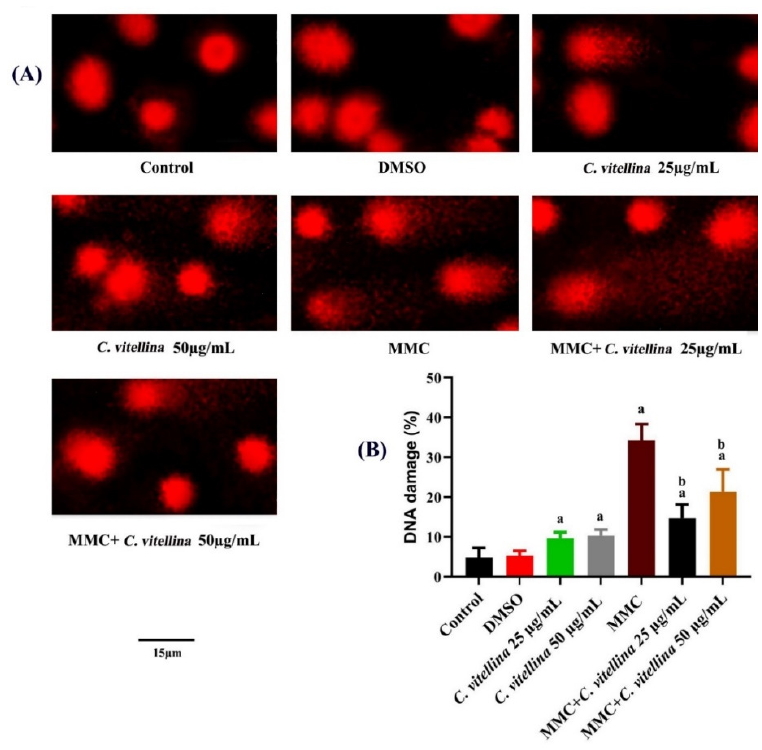
Figure 6. Photomicrographs of alkaline comet assay ( A ) showing the ameliorative e ff ect of C. vitellina extract on HPBL DNA-single strand breaks as evaluated by the migration of fragmented DNA after 24 h of treatments against MMC-induced genotoxicity (ethidium bromide staining, Olympus BX 41 fluorescent microscope, Tokyo, Japan). Significant di ff erences at ( p ≤ 0.05) with respect to untreated and MMC-treated groups are (a) and (b) respectively. Data were represented as (Mean ± SD) of three di ff erent experiments (n = 3), ( B ). MMC: Mitomycin C (0.5 µ g /